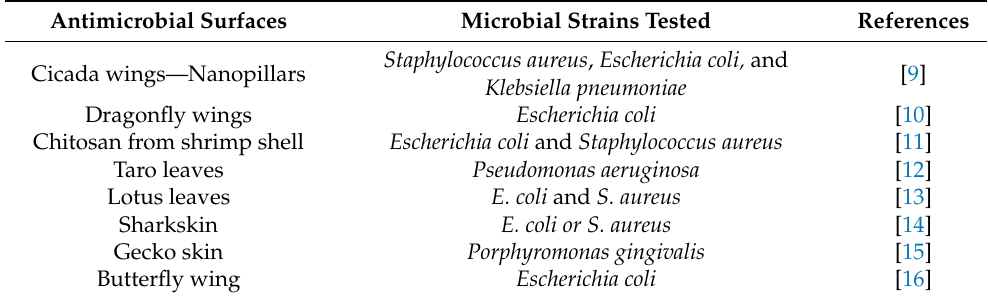
Table 1. List of natural antimicrobial structures. Antimicrobial Surfaces Microbial Strains